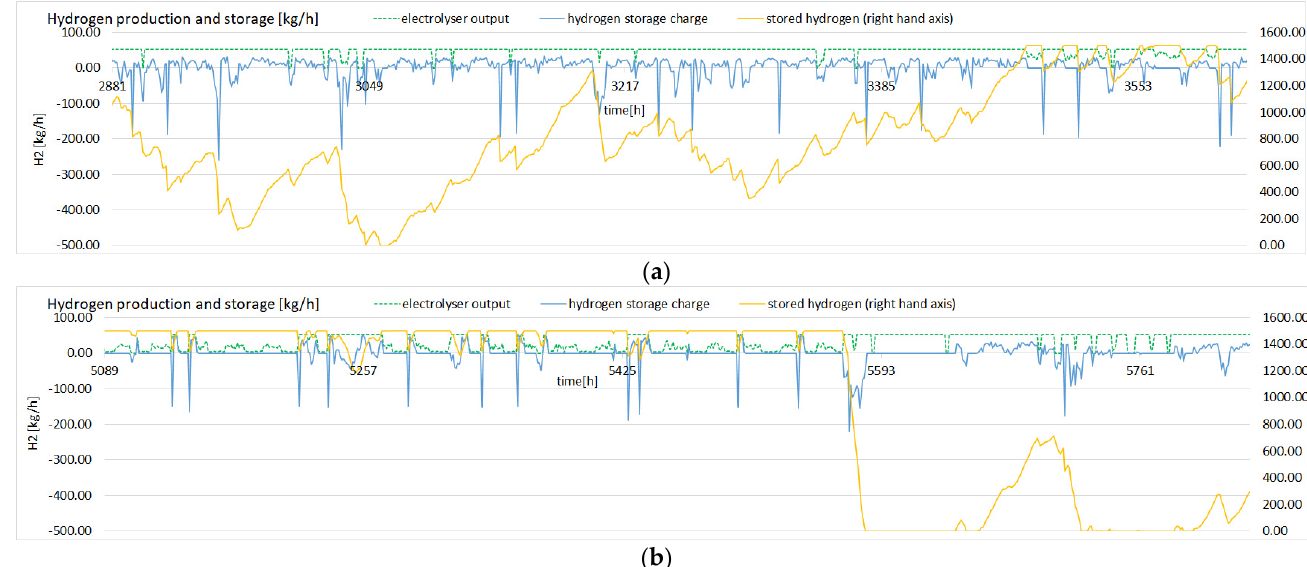
Figure 3. Case hydrogen production and storage (simulation results). ( a ) May; ( b ) August.